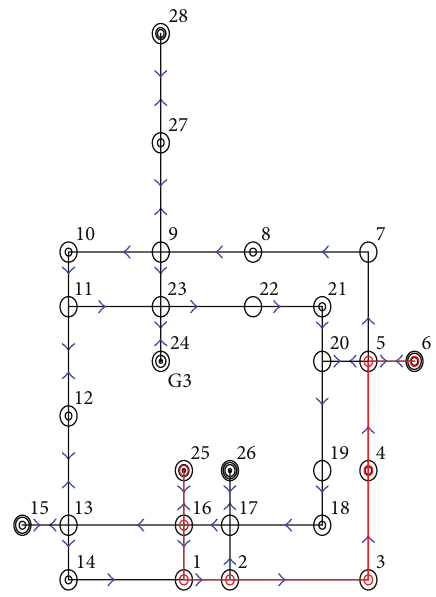
Figure 2: Taxi route from Gate 1 to Runway